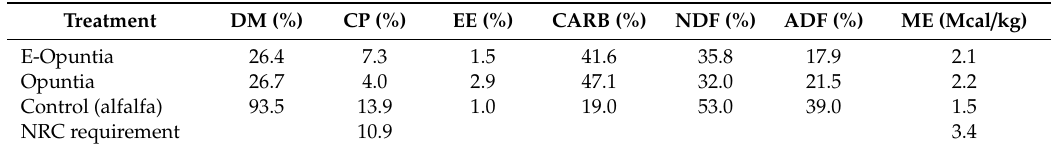
Table 1. Nutrient composition (DM basis) of the diets o ff ered during the last third of gestation and nutrient requirement for a 50 kg ewe